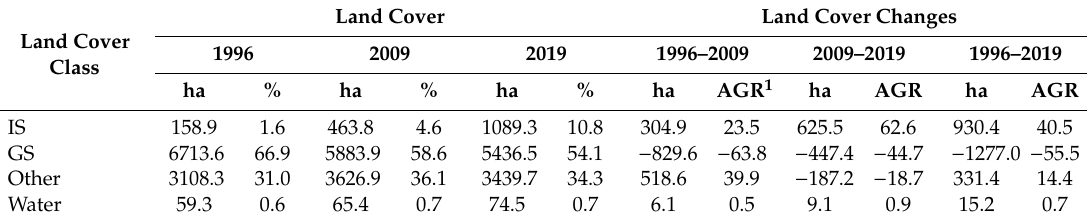
Table 1. Land cover changes in the Kurunegala urban area (KUA) area.